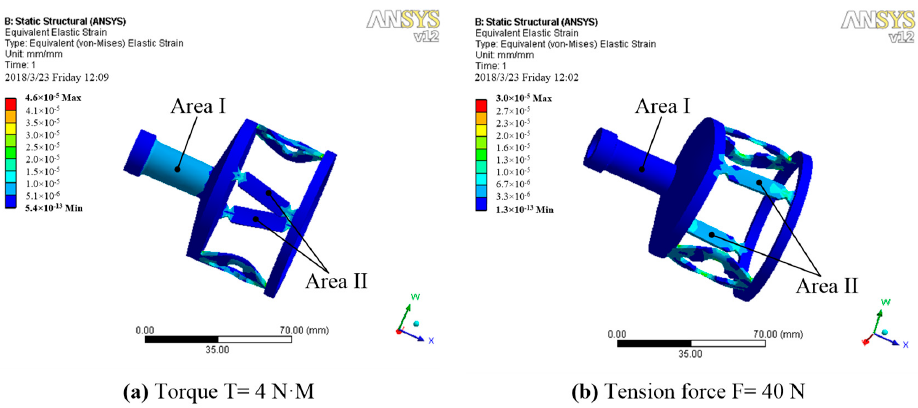
Figure 5. Strain distribution diagrams under different forces: ( a ) strain distribution at T = 4 N·M and ( b ) strain distribution at F = 40 N.